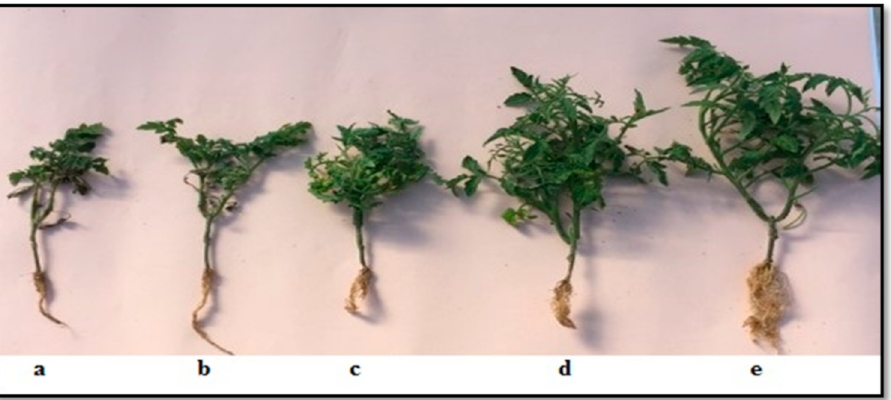
Figure 3. Treated tomato seedlings ( a ) Control, ( b ) ZnO-NPs, ( c ) Bacillus pumilis (N1), ( d ) Bacil- luspumilis (N1) + 20 mg L − 1 ZnO-NPs, ( e ) Bacillus pumilis (N1) + 40 mg L − 1